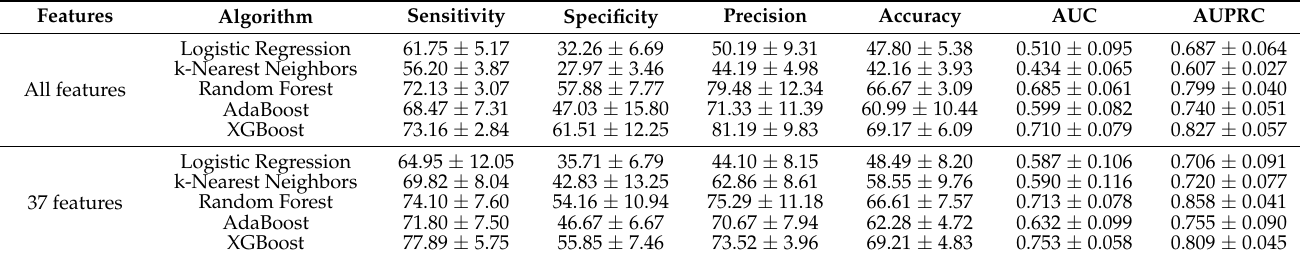
Table 1. Comparative performance among different machine learning algorithms using all radiomics features and top 37 features. The experiments were done and reported via 5-fold cross validation and SMOTE technique.